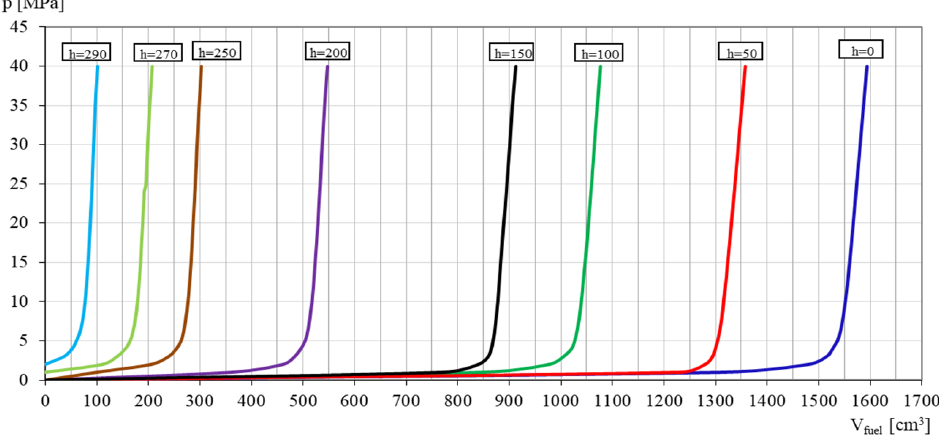
Figure 7. Change in the pressure in the measured volume at predefined piston positions for the 4% content of CO 2 in the exhaust gas.